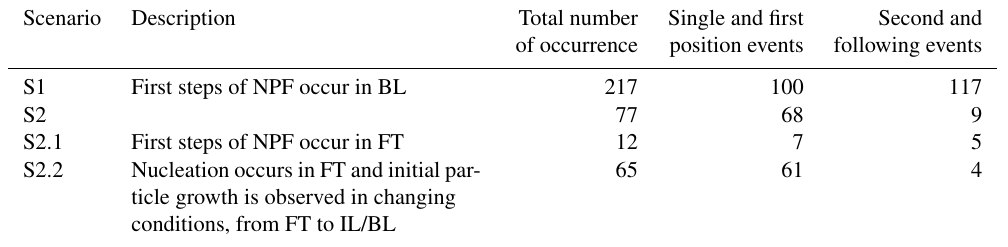
Table 3. Description of the scenarios concerning the location of the station in the troposphere (boundary layer, BL; interface layer, IL; and free troposphere, FT) during the first steps of the NPF process, i.e. from the appearance of the newly formed clusters (<3nm) to the time at which the concentration of 3–7nm particles was maximum. The total number of occurrence is provided for each scenario in the second column. Since multiple events are frequently observed at Chacaltaya, a more detailed classification including the event position is specified in the last two columns.